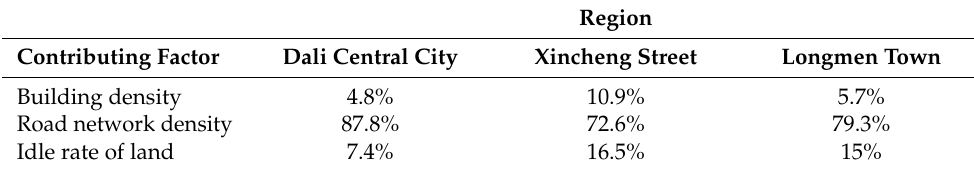
Table 10. Statistics for low-efficiency industrial land contribution.